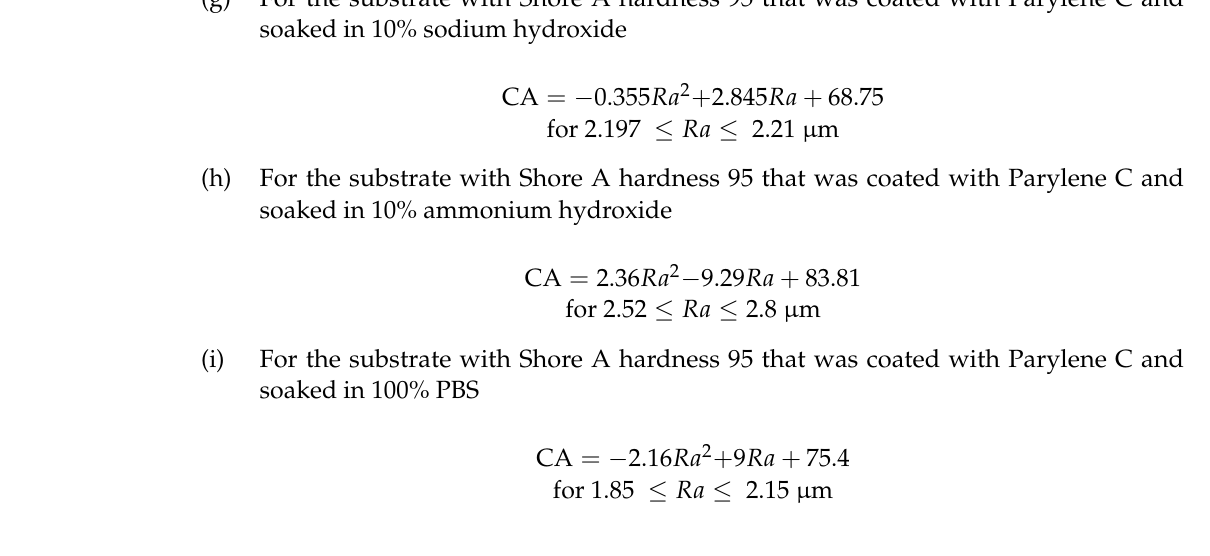
Table 2. Arithmetic average surface roughness (Ra) of uncoated and coated substrates.